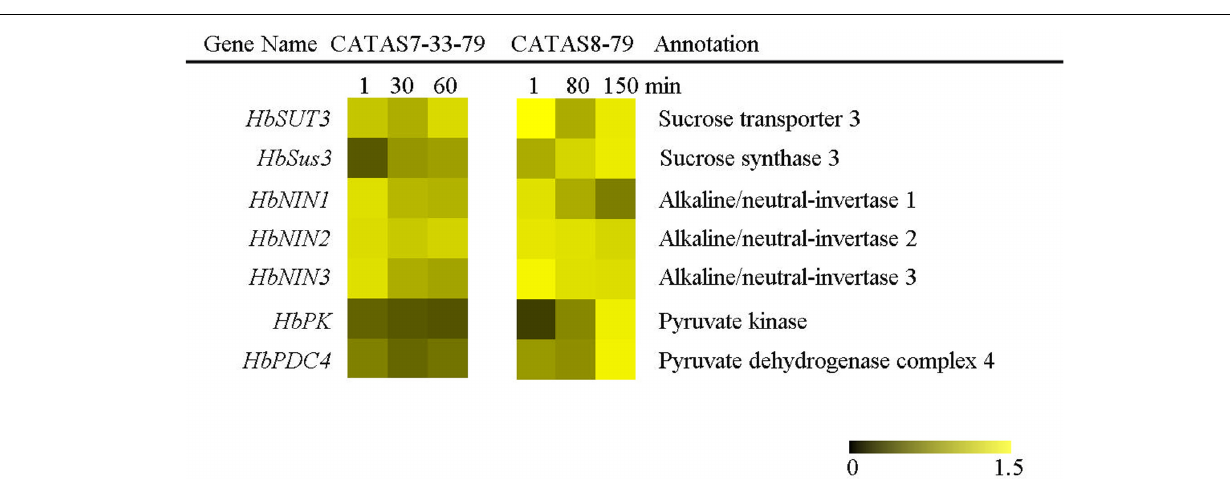
FIGURE 3 | The qRT-PCR analysis of carbohydrate metabolism-related genes across three stages of latex flow between CATAS7-33-97 and